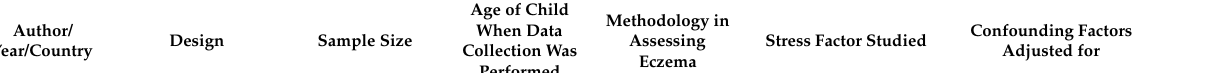
Postpartum depression shows positive association on the risk of questionnaire-diagnosed atopic dermatitis and physician-diagnosed atopic dermatitis among children at 3 years old. Questionnaire-diagnosed atopic dermatitis (through observation of symptoms) Adjusted OR: 1.17, 95% CI: 0.97–1.41, p = 0.094 Physician-diagnosed atopic dermatitis